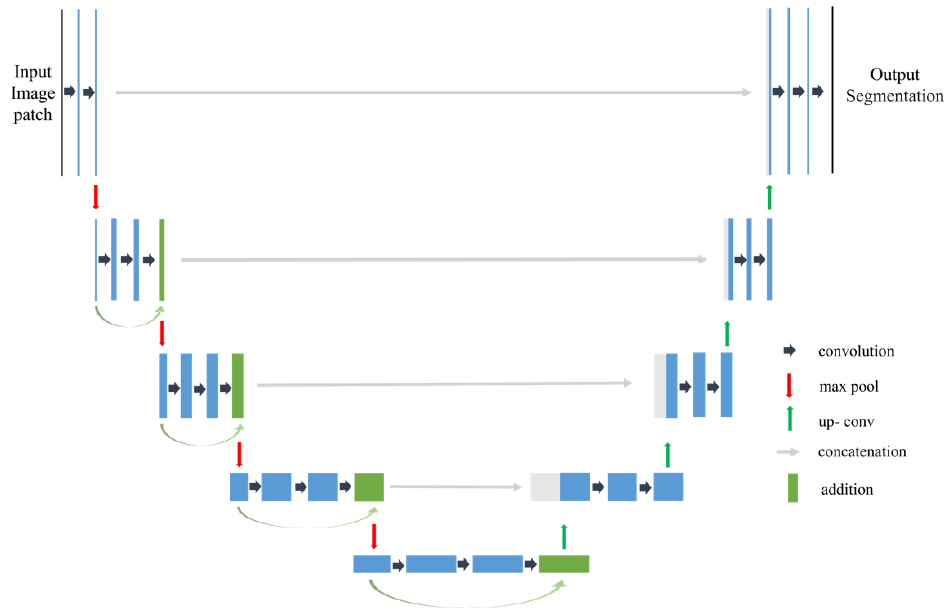
Figure 3. U-net architecture with the encoding (left) and decoding (right) sections that produce the characteristic U-shape of the architecture, producing pixel-wise classification of the input imagery. ResNet layers forms the encoder.